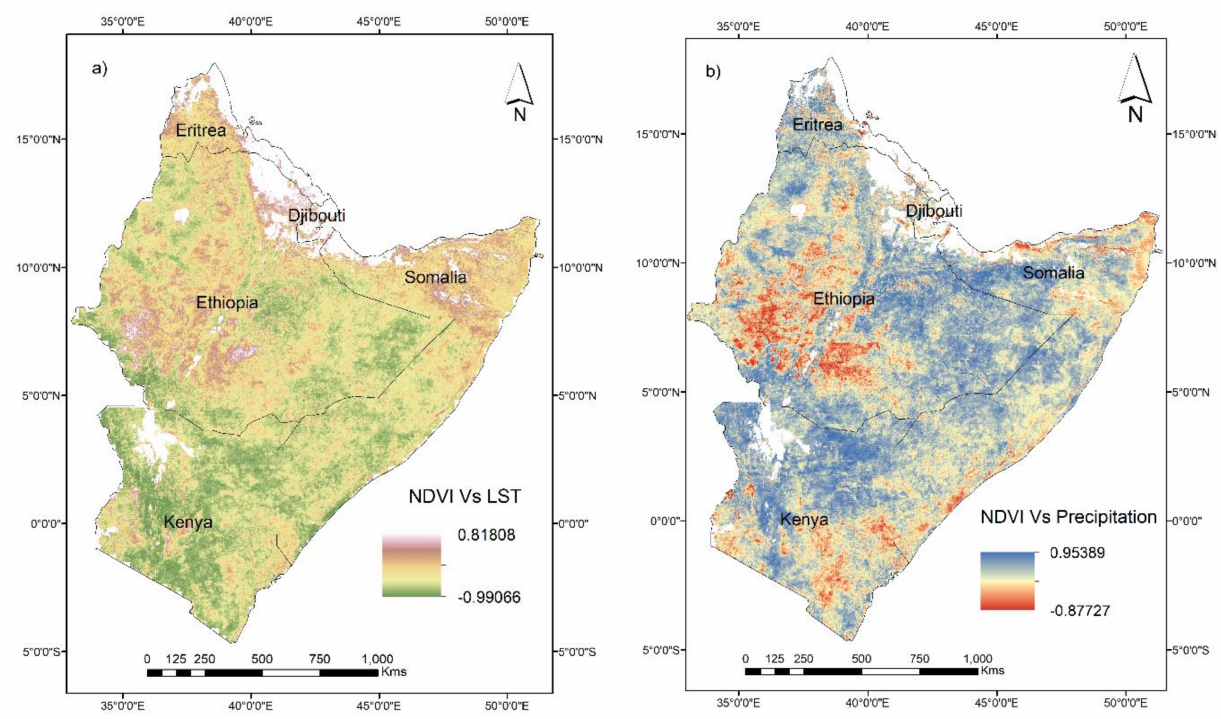
Figure 6. ( a ) Pixel-based correlations of annual mean NDVI versus land surface temperature ( a ) and versus precipitation ( b ) over the Horn of Africa during